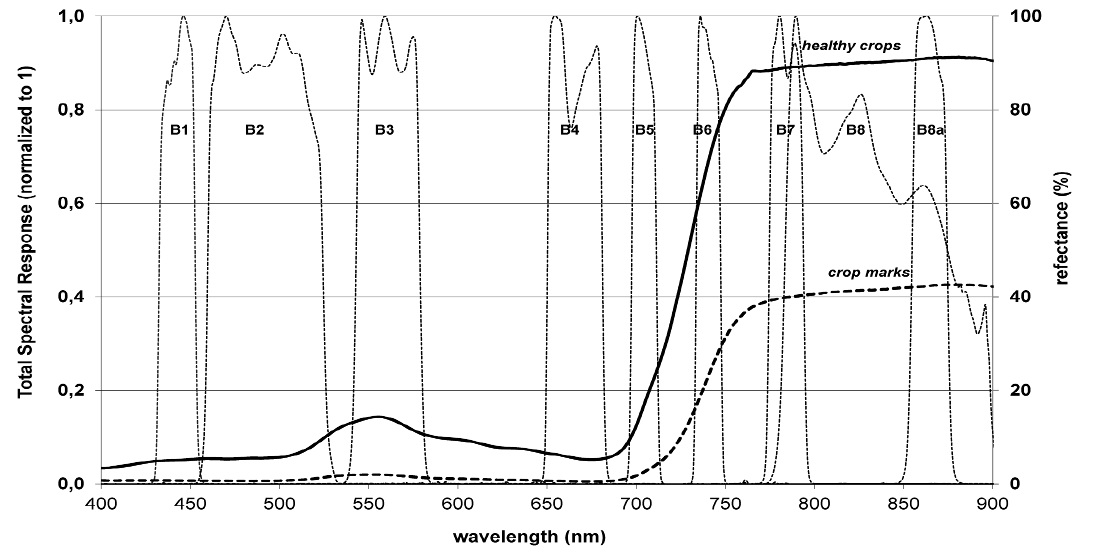
Figure 3. Relative Spectral Response of Sentinel-2 (Bands 1–8a). Typical spectral signatures of healthy crops and crop marks (dash line) are also